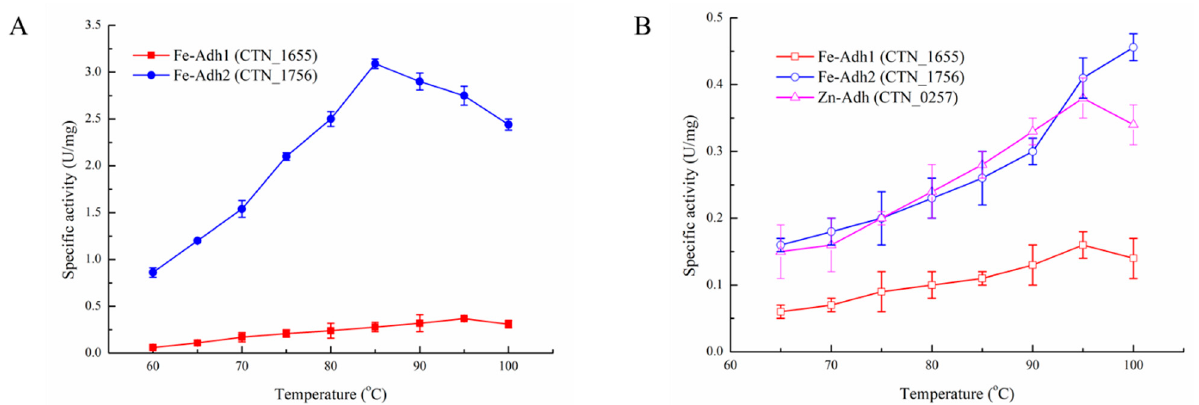
Figure 1. The effects of temperatures on the enzymatic activity of the three Adhs from T. neapolitana : ( A ): forward reaction for Fe-Adh1 and Fe Adh2; ( B ): reverse reaction for Fe-Adh1, Fe-Adh2, and Zn-Adh. All of the enzymatic activity was determined at pH 7.0. All of the activity assays were performed in triplicate, and data reported here are the mean of the three replicates.